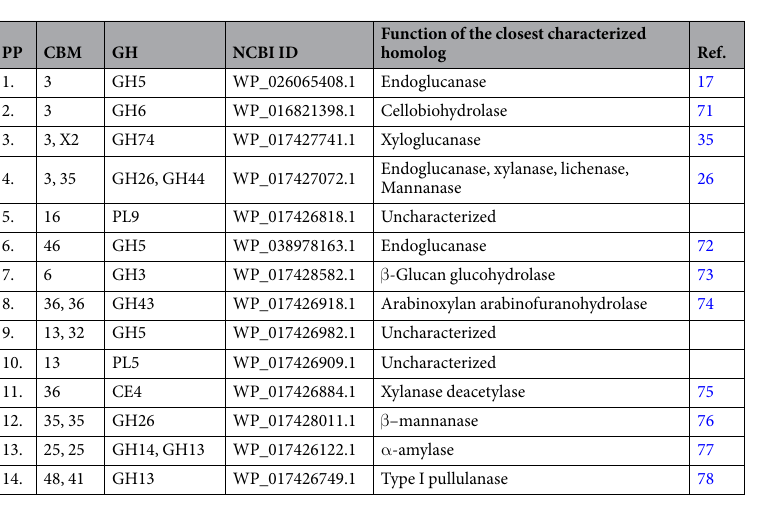
Table 1. CBM-containing polypeptides of P . Polymyxa A18 used for expression